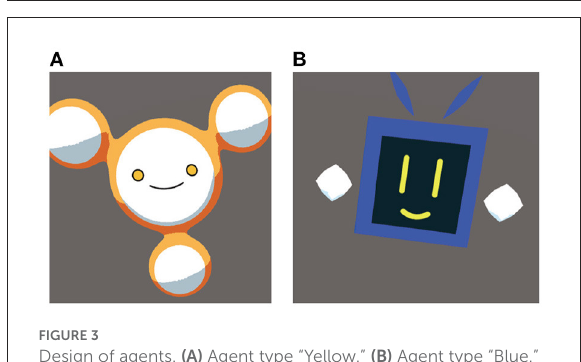
FIGURE3 Design of agents. (A) Agent type “Yellow.” (B) Agent type “Blue.” These agents were used under with-agent and with-migrate-agent